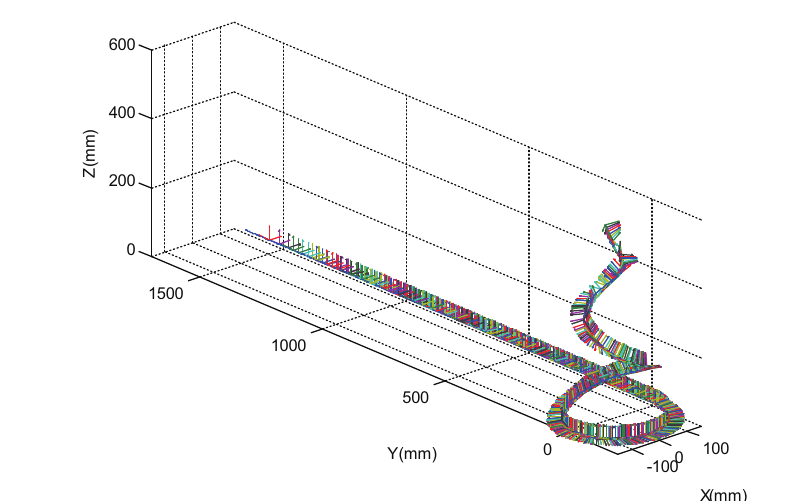
Figure 6. Establishment of local coordinates.